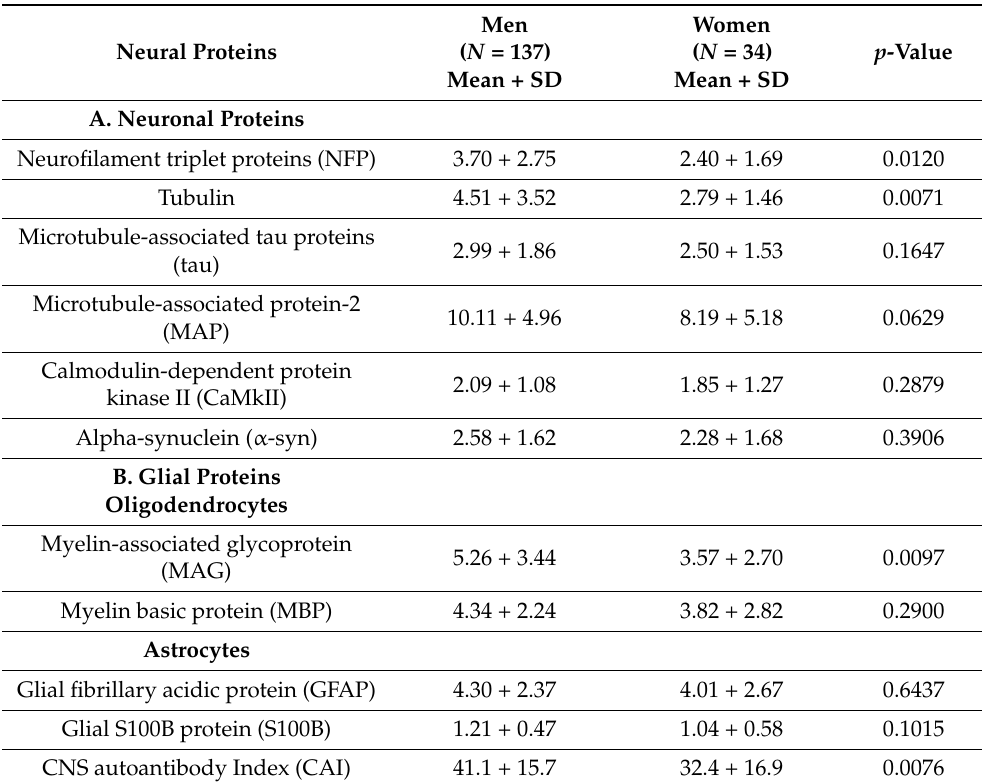
Table 2. Autoantibody ANCOVA analysis comparing men and women with Gulf War illness (GWI).